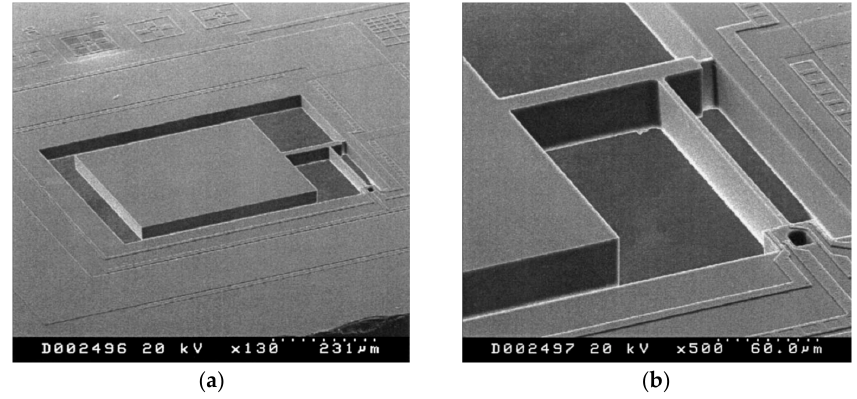
Figure 38. A resonant accelerometer: ( a ) The structure was brought under resonance using a thermal actuator embedded at the base of connector beam ( b ). Strains were measured using doped piezoresistors [321]. Reproduced with permission from Aikele, M. Sens. Actuators Phys. ; published by Elsevier,